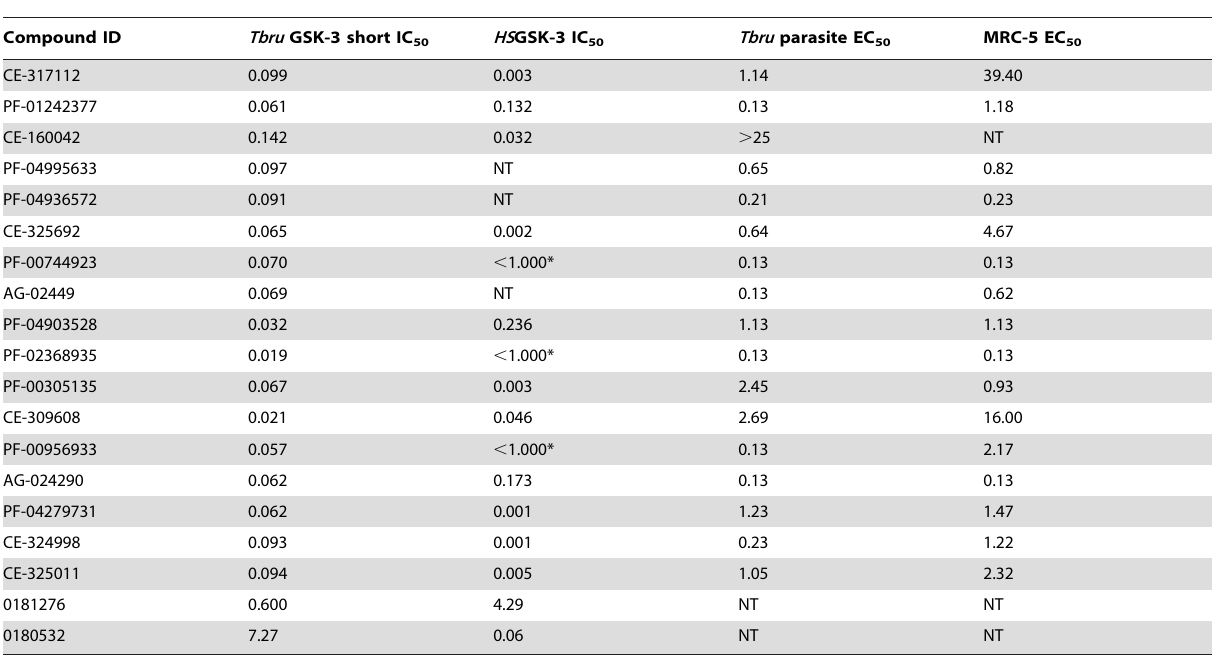
Table 1. GSK-3 Enzyme, Antiparasitic and cytotoxicity testing (values in m M).